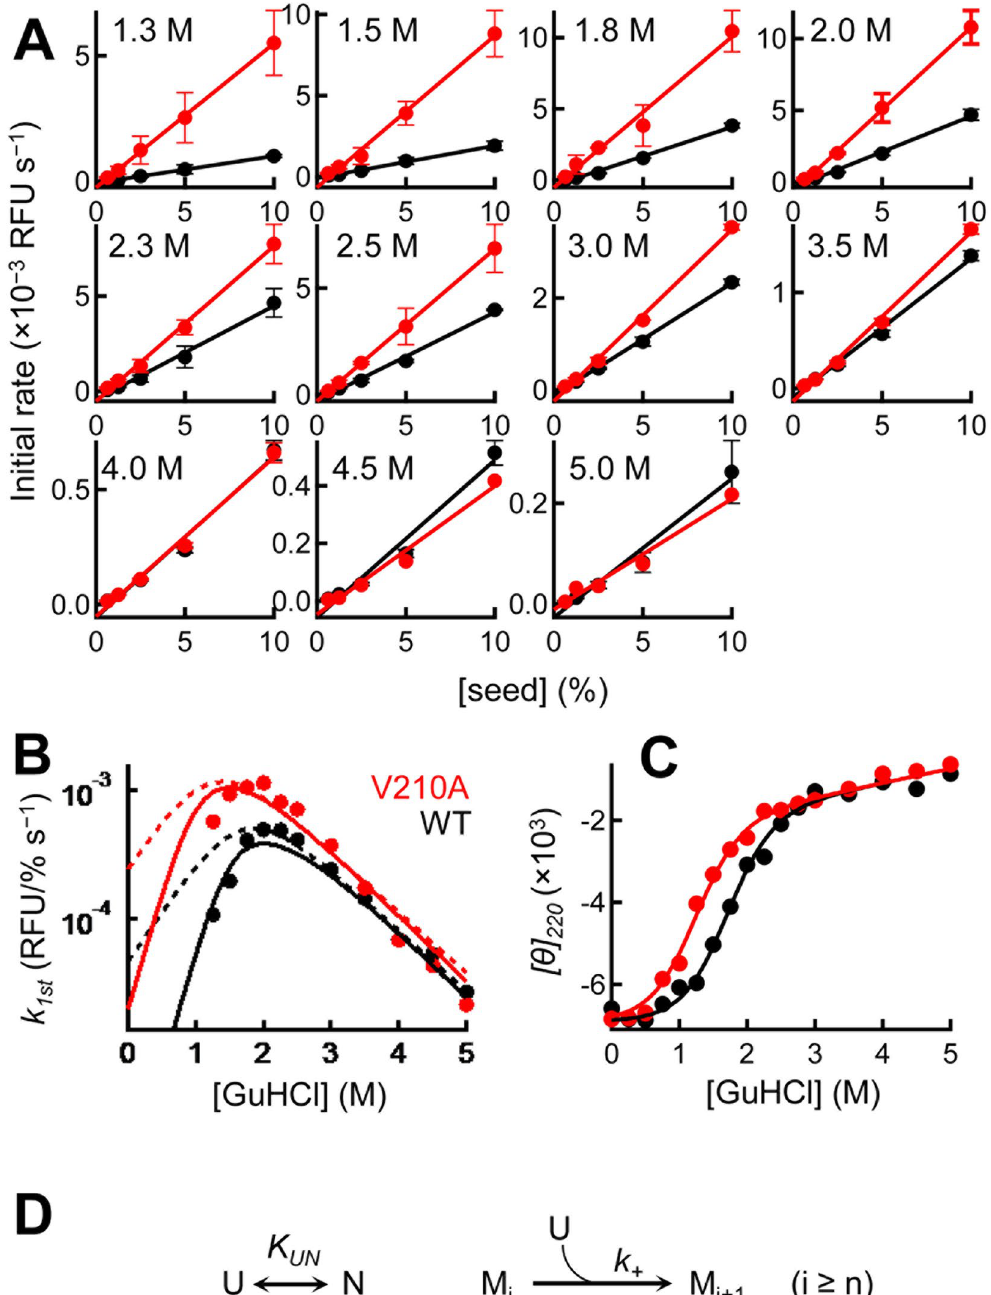
Figure 2. Effects of varying the seed concentration on amyloid growth. ( A ) Initial rates of the growth reaction (WT [black] and V210A [red]) as a function of the seed concentration. The GuHCl concentrations in the reaction mixtures are shown in the top left of each images. The monomer concentration was 18 µ M in all experiments. ( B ) Pseudo-first order rate constants of WT (black) and V210A (red circles) as a function of the GuHCl concentration. The dotted and solid lines represent least-squares fits to the one-step (Fig. 2D) and the native-state inhibition models (Fig. 5), respectively. ( C ) Equilibrium unfolding curves of monomeric WT (black) and V210A (red) obtained by CD. Solid lines represent a least-square fits to the two-state unfolding model. ( D ) One-step reaction model for amyloid growth. M i represents an amyloid fibril with the polymerization degree of i and n is the size of the critical nucleus. U and N is the unfolded and native state of PrP,